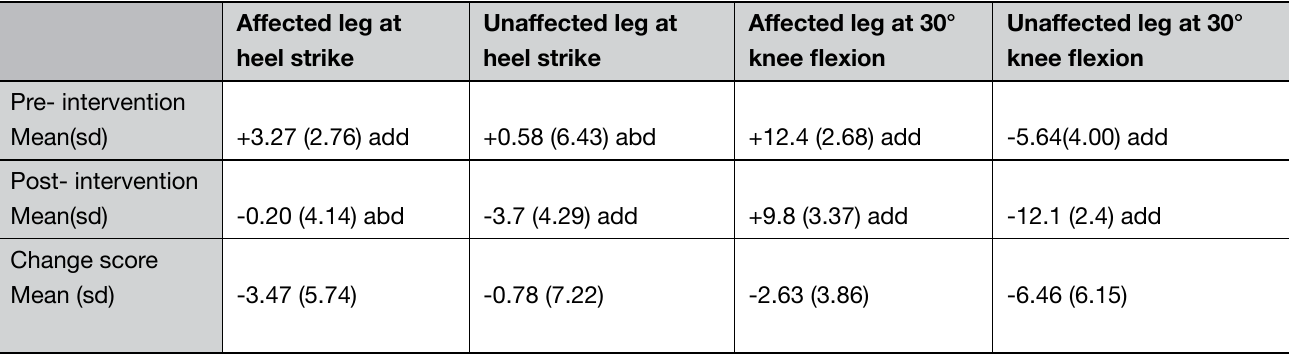
Table 1: Means (sd) of pre- and post-test scores for the position of the affected and unaffected hips at two points in the running cycle, measured in